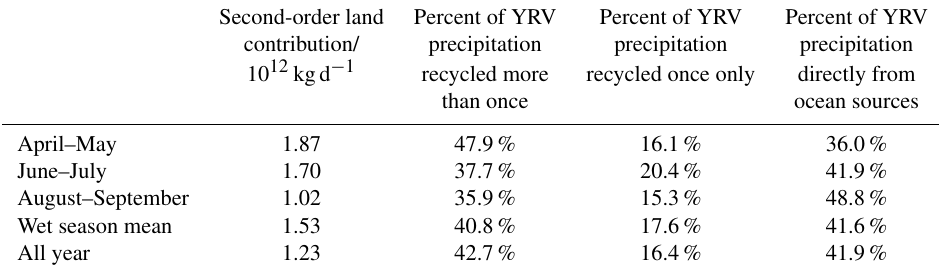
Table 2. Second-order moisture sources to YRV.